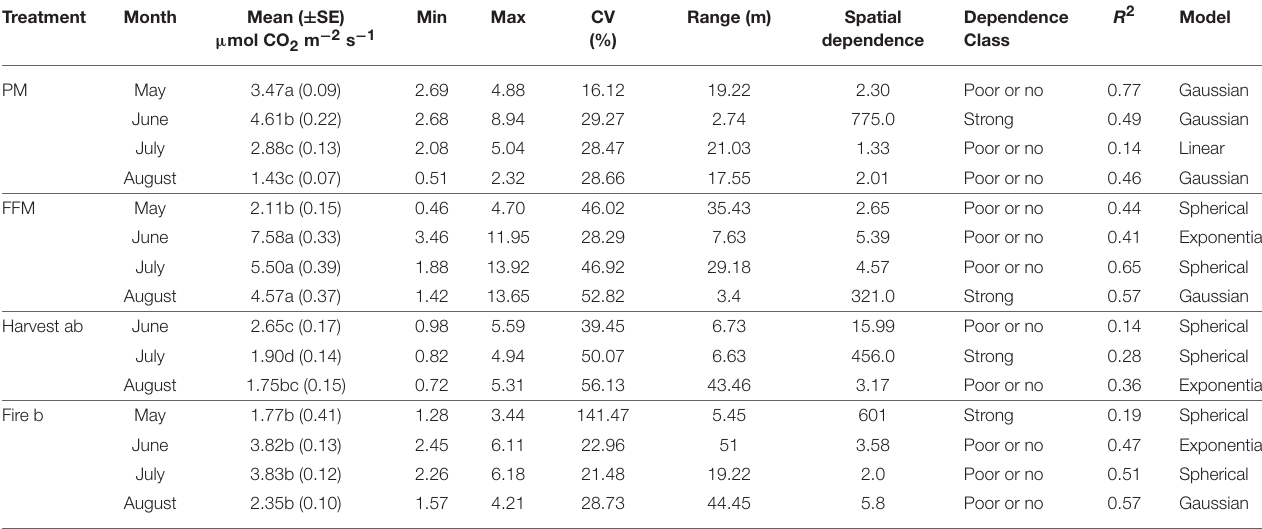
TABLE 3 | Soil respiration of research sites including peat mineral-mix (PM), forest floor mineral-mix (FFM), Harvest ab by timber harvesting disturbed a/b ecosite, Fire b a by forest fire disturbed type b ecosite.